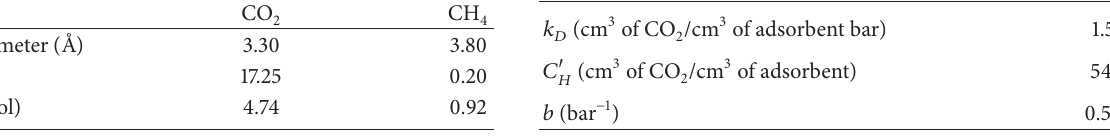
Table 2: Activation energies for permeation for 6-FDA based membranes at 35 ∘ C and 20 atm.